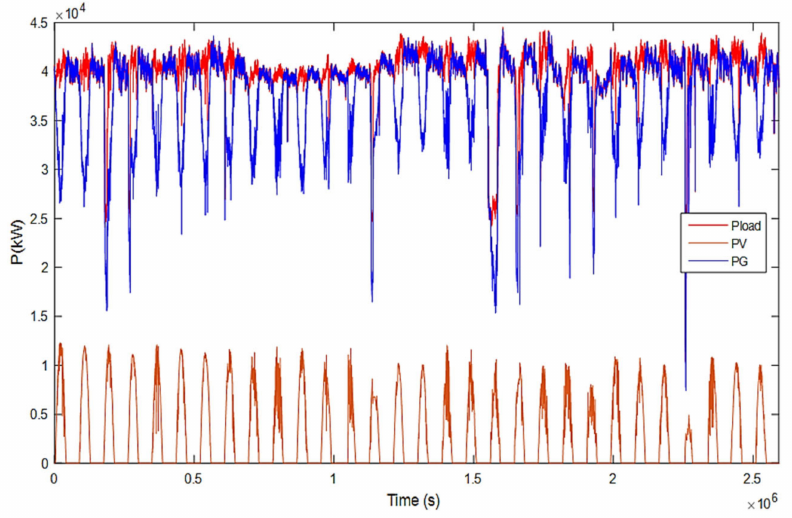
Figure 15. Interaction phenomena between solar production and thermal production and electricity demand. Developing Models in Quasi-Static Solar Profile (QSP) or Dynamic Solar Profile (DSP) Conditions